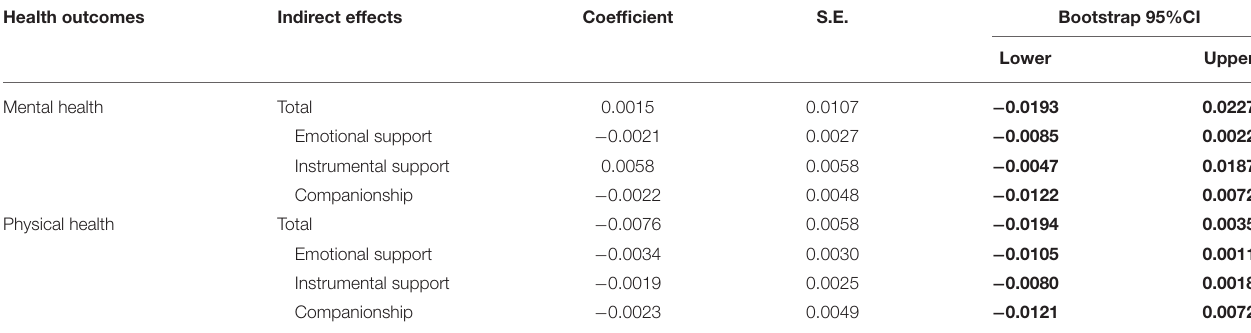
TABLE 4 | Mediation effects of the subtypes of social support in the association between widowhood and health status in the male subsample ( N = 3,563). Health